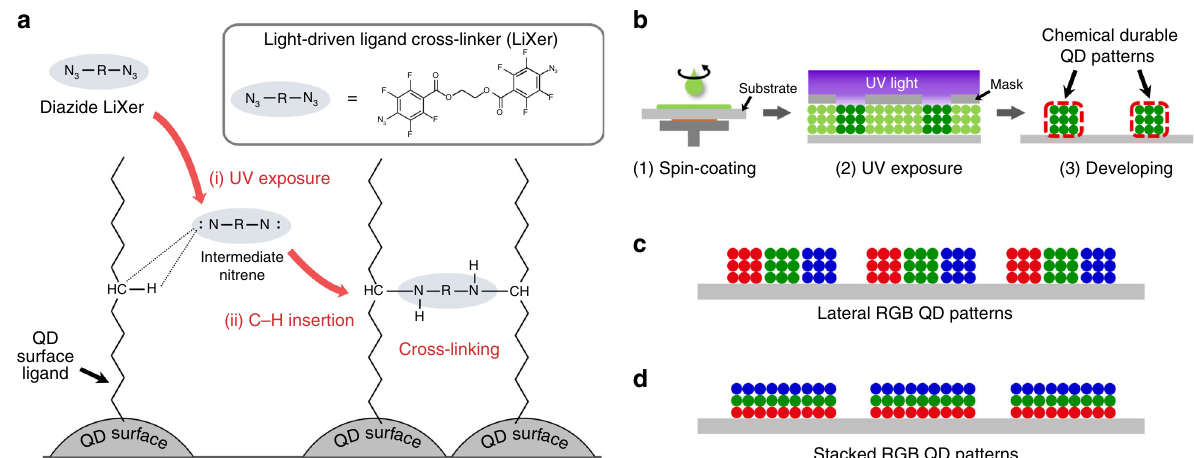
Fig. 1 Schematic illustration of QD patterns using LiXer. a Schematic description of the ligand crosslinking process between neighbouring QDs based on the C – H insertion reaction of the nitrene moiety of LiXer. The inset shows the chemical structure of ethane-1,2-diyl bis(4-azido-2,3,5,6-tetra fl uorobenzoate), used as the LiXer in this study. b Schematic description of the photo-patterning processes of QDs using LiXer. c Laterally positioned patterns and d vertically stacked patterns of RGB QDs, achievable from consecutive applications of the photo-patterning